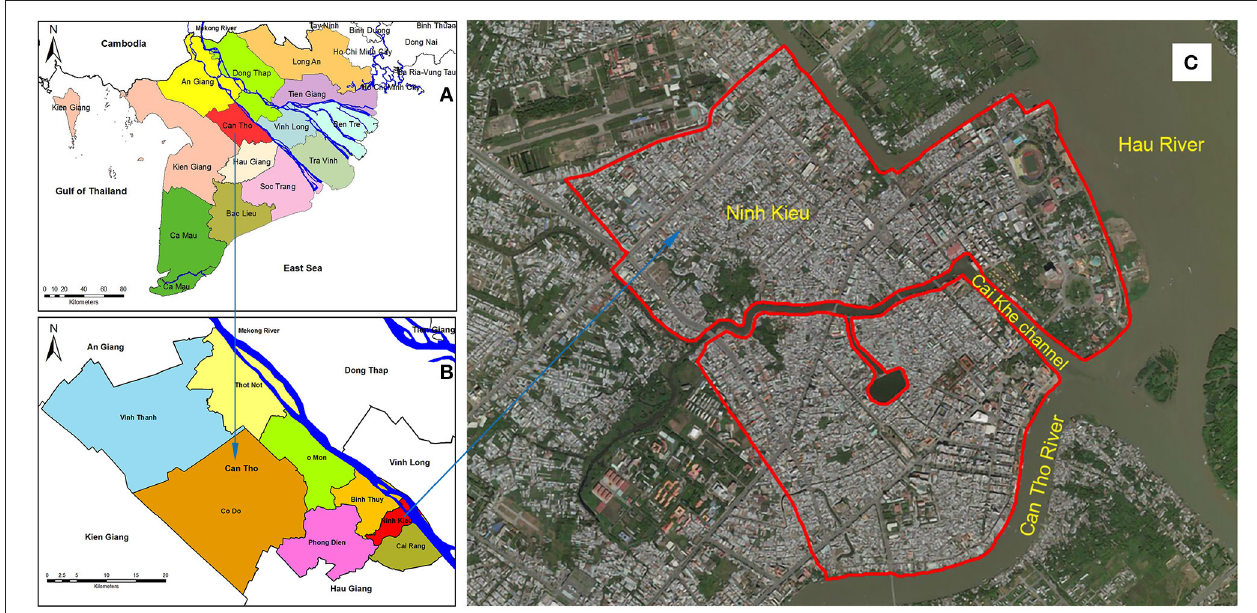
FIGURE 1 | (A) Map of Mekong delta and surrounding provinces, (B) Can Tho city, (C) Study area (bounded by red line) within the Ninh Kieu district in Can Tho city (Base map is from Bing Maps satellite ©